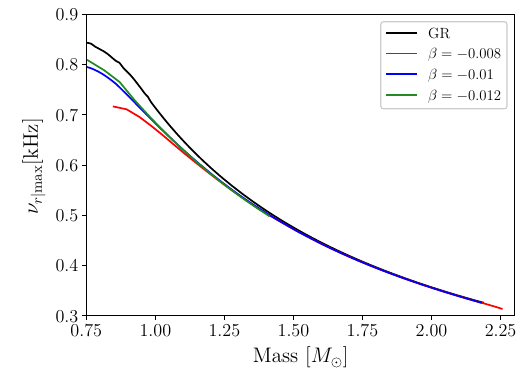
Fig. 9 ISCO radius (physical) as a function of the gravitational mass forGRandTMSTwiththemonotoniccouplingfunction(12),for n = 1, different β values and f = 0 Hz